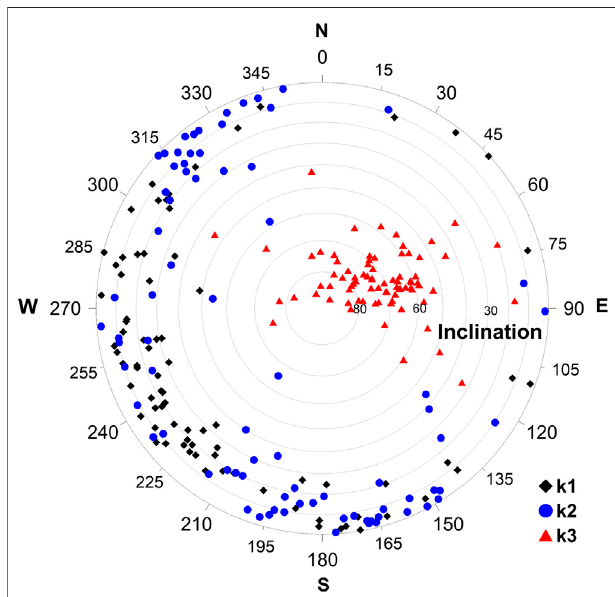
FIGURE 6 | Directions of the anisotropy of the magnetic susceptibility, plotted as stereographic projection on the upper hemisphere. Red triangles represent Kmin directions pointing predominantly to the east (northeast), black spades stand for Kmax directions and blue circles represent Kint